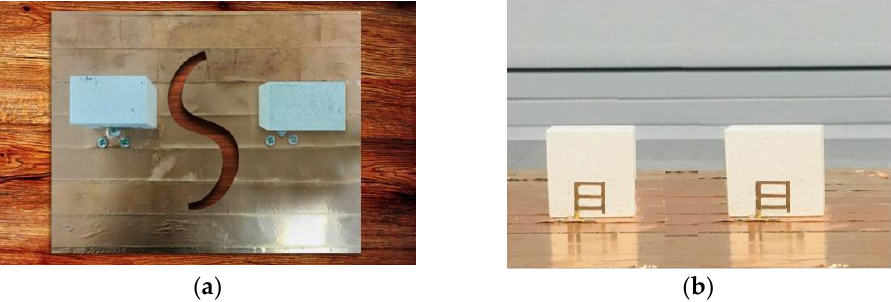
Figure 15. Photographs of a fabricated, circularly polarized, wideband MIMO antenna: ( a ) Top view with DGPS; ( b ) Front view without DGPS.